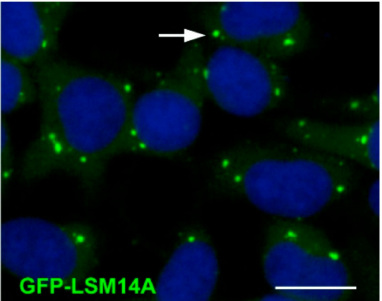
Figure 3. P-bodies labelled with GFP-LSM14A in HEK293 cells. The white arrow indicates a P-body. DAPI-stained nuclei are in blue. Scale bars: 10 µ m. Source: Hubstenburger et al., 2017